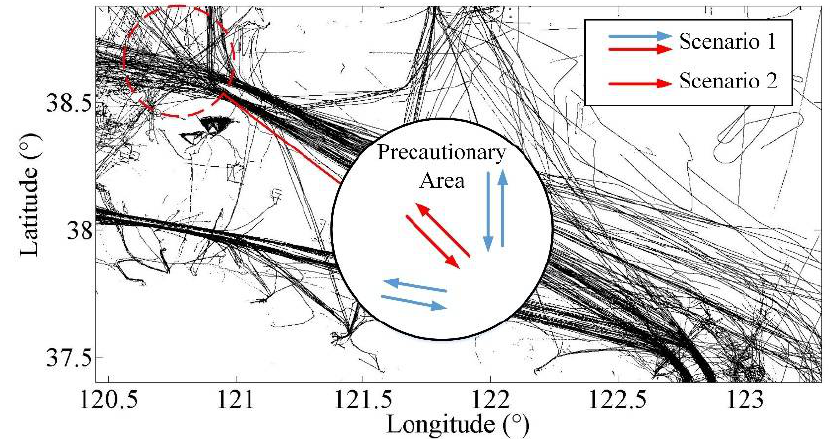
Figure 10. The location of Laotieshan PA and its main traffic flows.